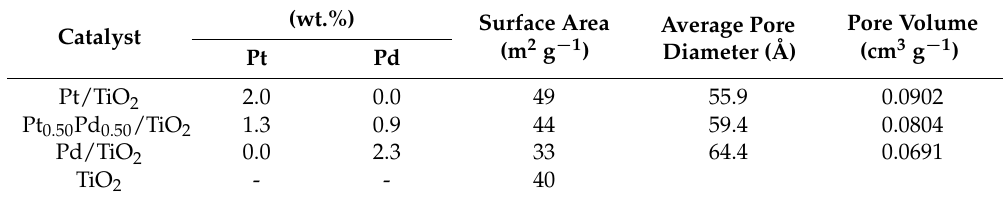
Table 1. Brunauer-Emmett-Teller (BET) surface area and chemical composition of the samples determined by BET and